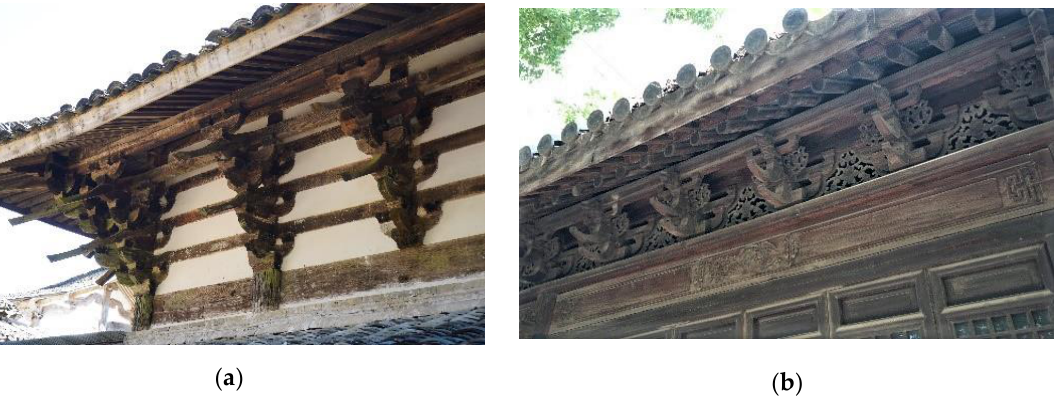
Figure 1. Two samples of the Dou-gong from the Yuan dynasty and Ming dynasty: ( a ) Shi-si Temple, Li-shui, Zhe-jiang, Yuan dynasty; ( b ) Wen Miao, Su-zhou, Jiang-su, Ming dynasty.